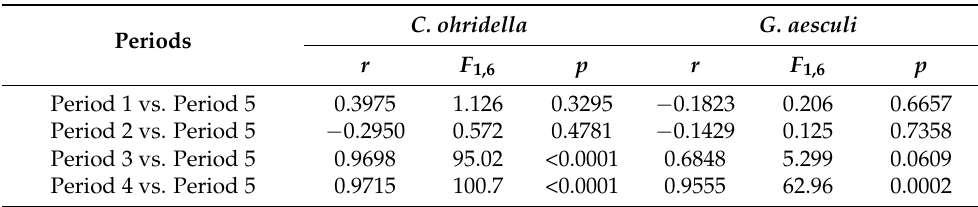
(Table 4). The same applies to data collected in mid-June, whereas data collected in mid- July and mid-August were more strongly correlated with the final damages. Table 4. Correlations between damages caused by C. ohridella and G. aesculi assessed at two different sampling